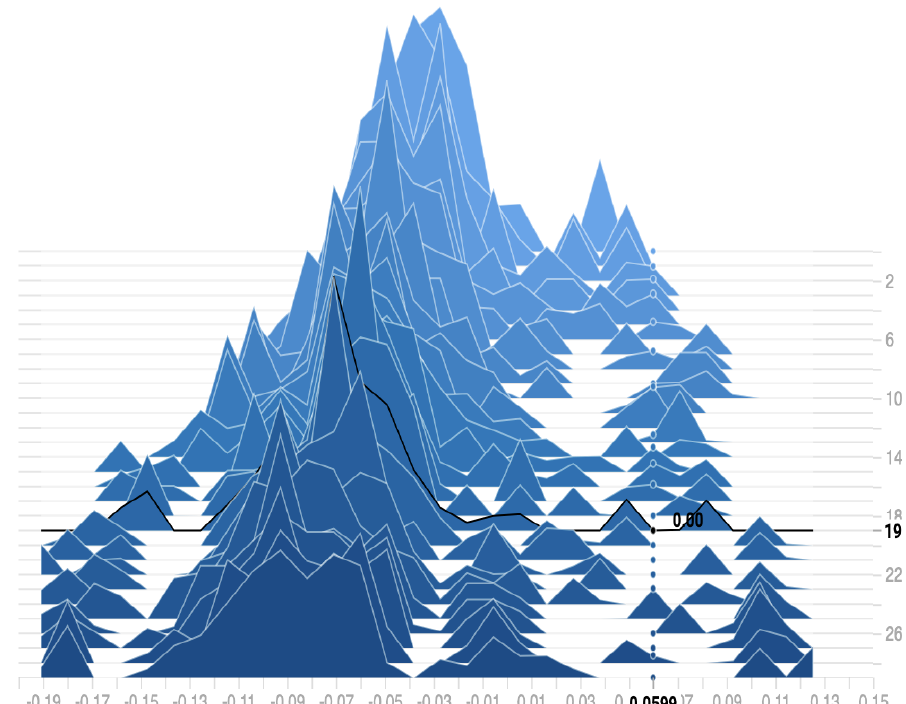
Figure 11. Distribution of the bias along the 30 epochs.